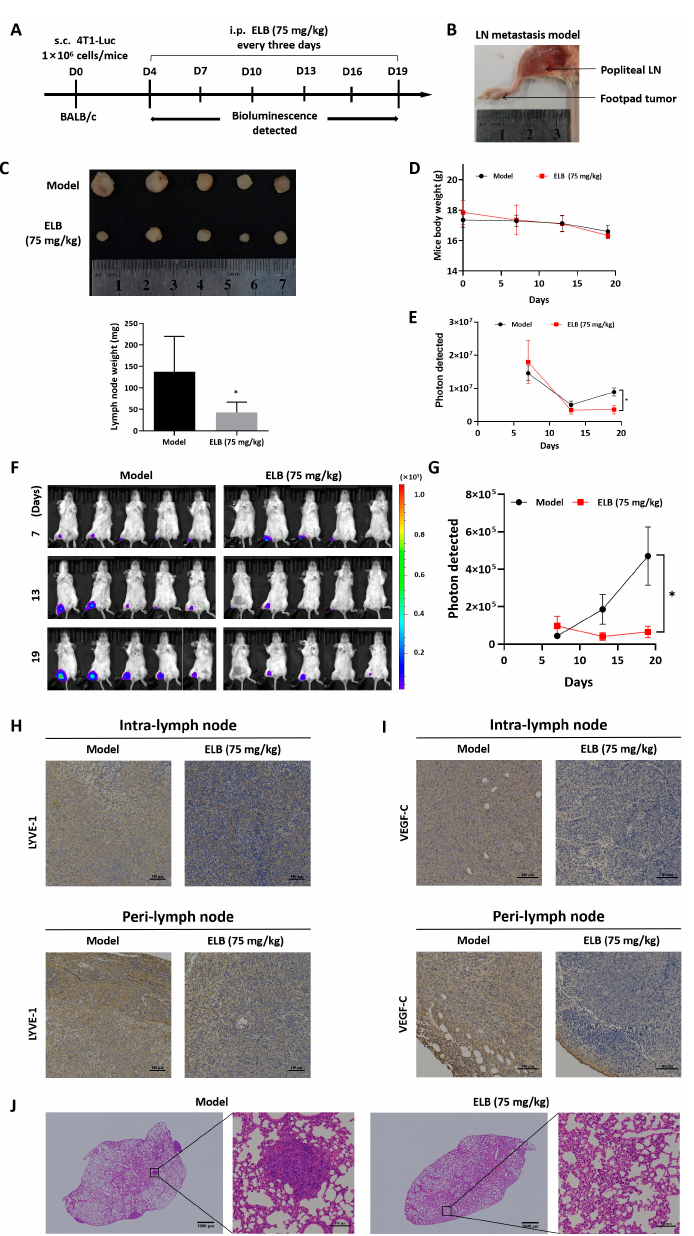
Figure 9. Eltrombopag suppressed lymph node metastasis of 4T1-Luc cells in vivo . ( A ) Experimental timeline of 4T1-Luc lymph node metastasis model. ( B ) Representative images of popliteal lymph node in a mouse model. ( C ) The appearance and weight of popliteal lymph node. ( D ) Body weight of tumor-bearing mice. ( E ) Bioluminescent data analysis in primary tumor site after treatment with eltrombopag. ( F , G ) Bioluminescent images and data analysis of popliteal lymph node metastasis after treatment with eltrombopag. ( H ) Lymphangiogenesis analysis in different sections of lymph node, lymph-vessel analysis IHC using antibodies of LYVE-1 (Scale bar: 100 µ m). ( I ) Sections of popliteal lymph node in different groups, submitted to IHC using antibodies of VEGF-C (Scale bar: 100 µ m). ( J ) Representative images of H&E-stained lymph node sections (Scale bar: 1000 µ m). LN: lymph node. Mean ± SD. n = 5. * p < 0.05 ( t